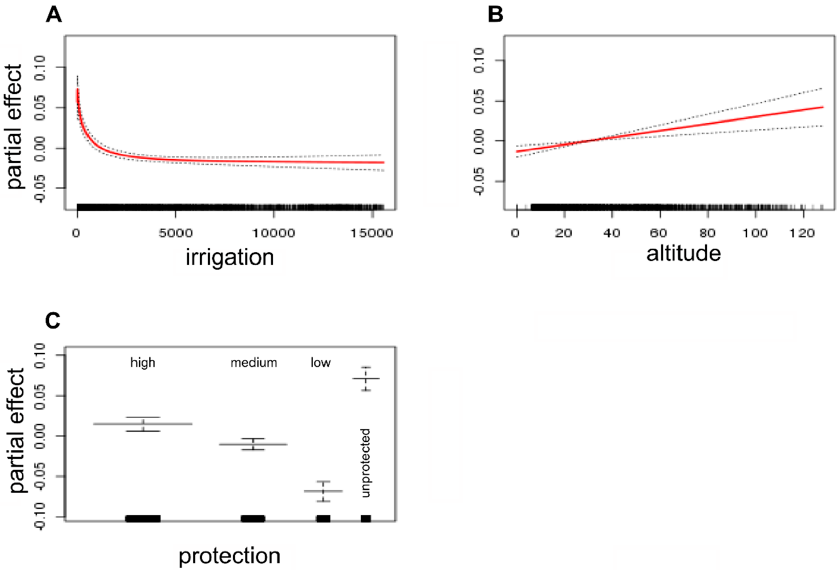
Figure 9. Partial effect of predictors in the best gam model for annual hydroperiod trend corrected for precipitation (Kendall’s tau) for all water bodies; ( A ) Irrigation = smoothing spline of log distance to irrigated cultures; ( B ) altitude = altitude above sea level; ( C ) protection = protection level (factor, four levels).